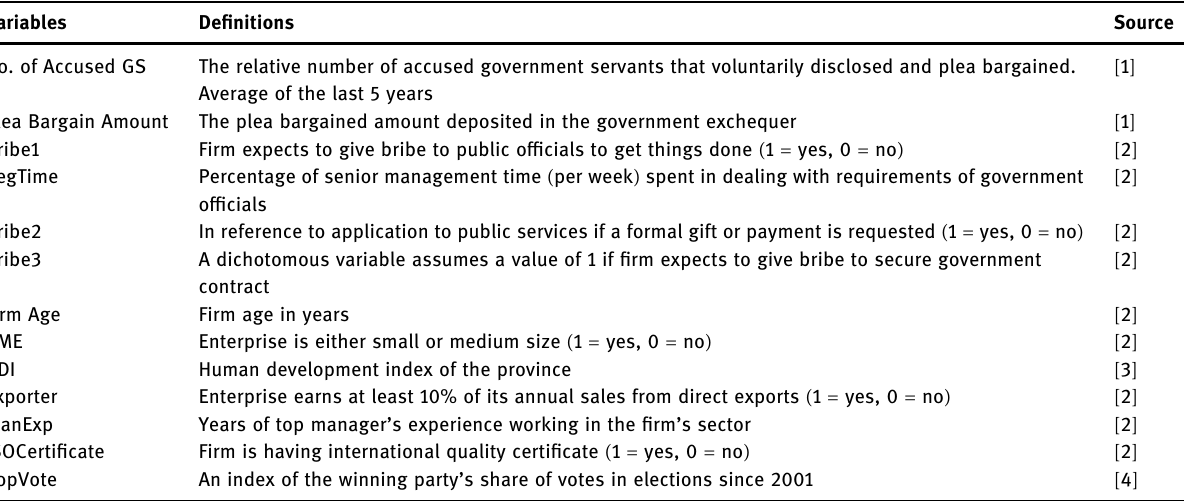
Table 1: Variable de fi nitions and sources Variables